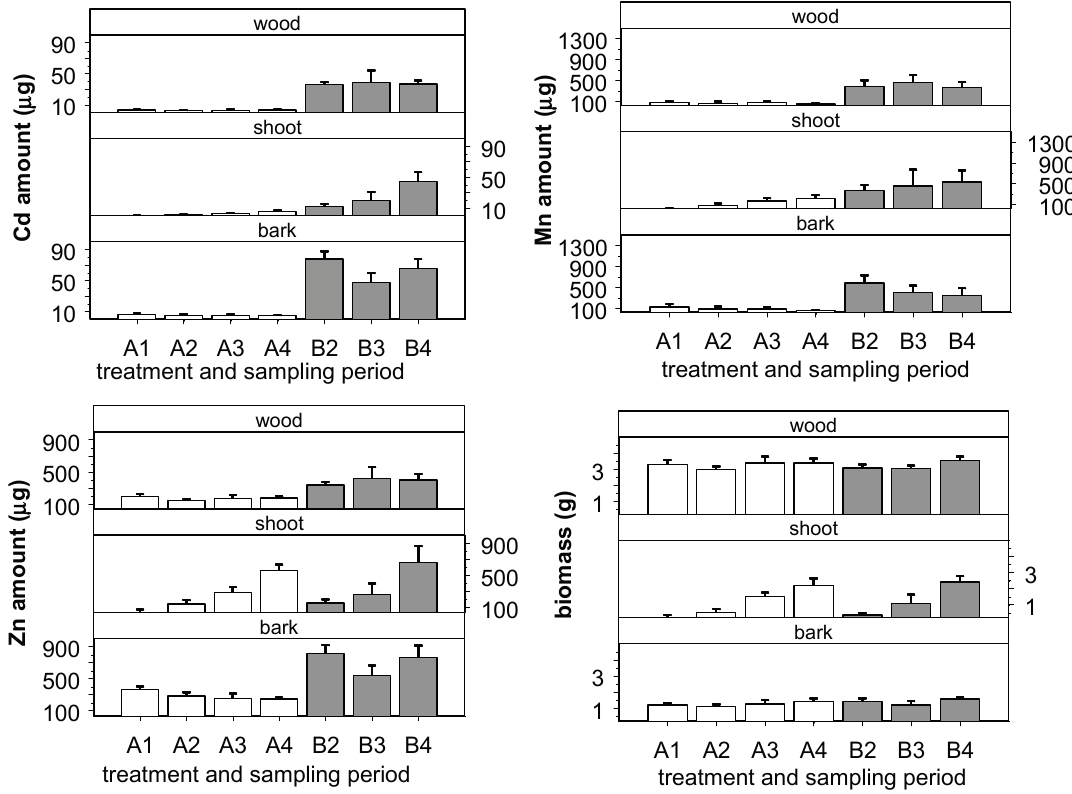
Figure 5. Biomass (expressed on a dry weight basis) and amount of Cd, Mn and Zn in wood, shoot and bark per cutting of two origins of willow cuttings (A, cuttings from an uncontaminated location; B, cuttings from a contaminated location) sampled after (1) 4, (2) 8, (3) 12 and (4) 16 weeks growing in the corresponding soil types of the location. Values are the averages of four replicates per treatment per sampling event (error bars indicate the standard deviation for four